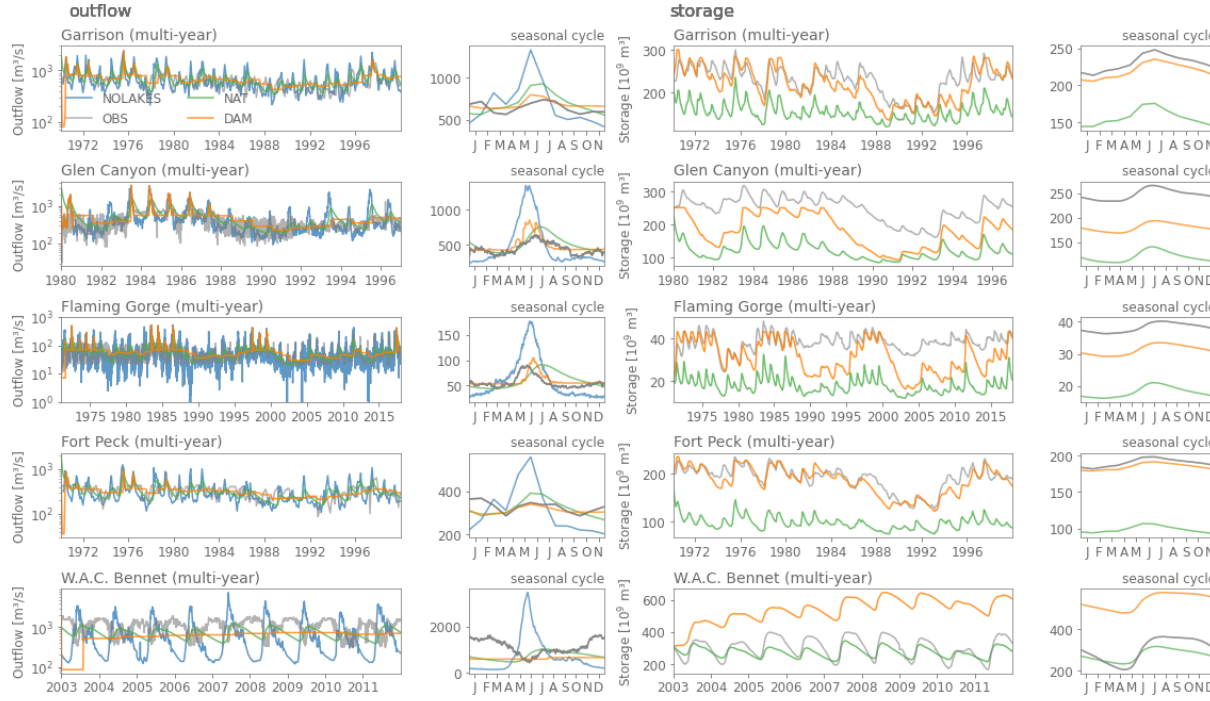
Figure A3. The same as Fig. A2 but for non-irrigation